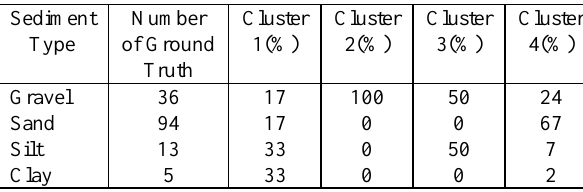
Table 3: Cross tabulation between the GLCM Entropy cluster map and ground truth